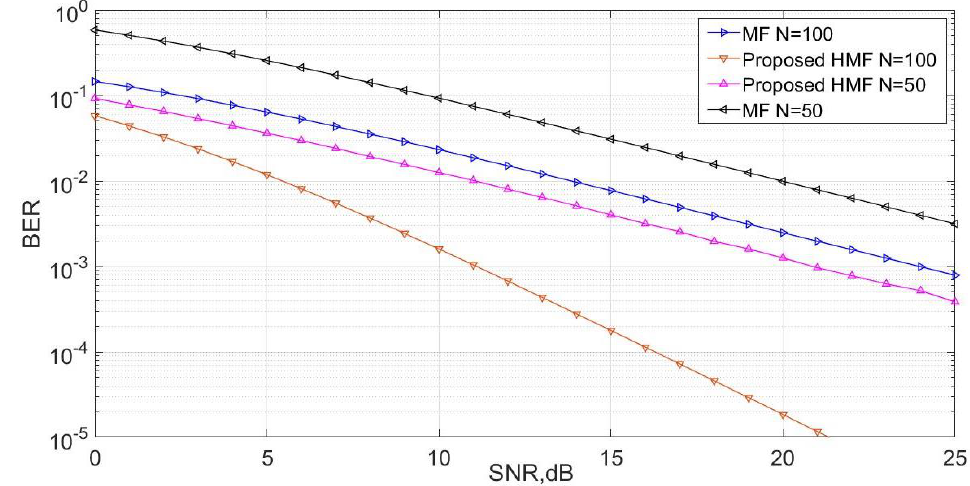
Figure 9. SNR Vs. BER performance for HMF and MF, considering number of samples = 50 and 100 in the Rician Channel.